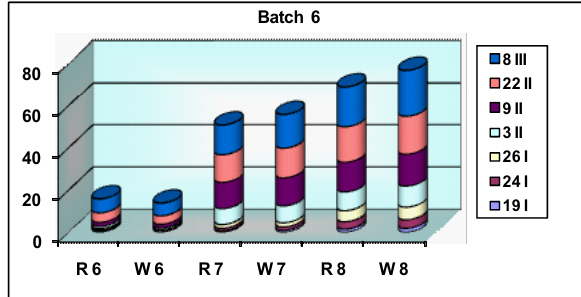
Fig. 10. The final average length of the branches, in cm, for batch